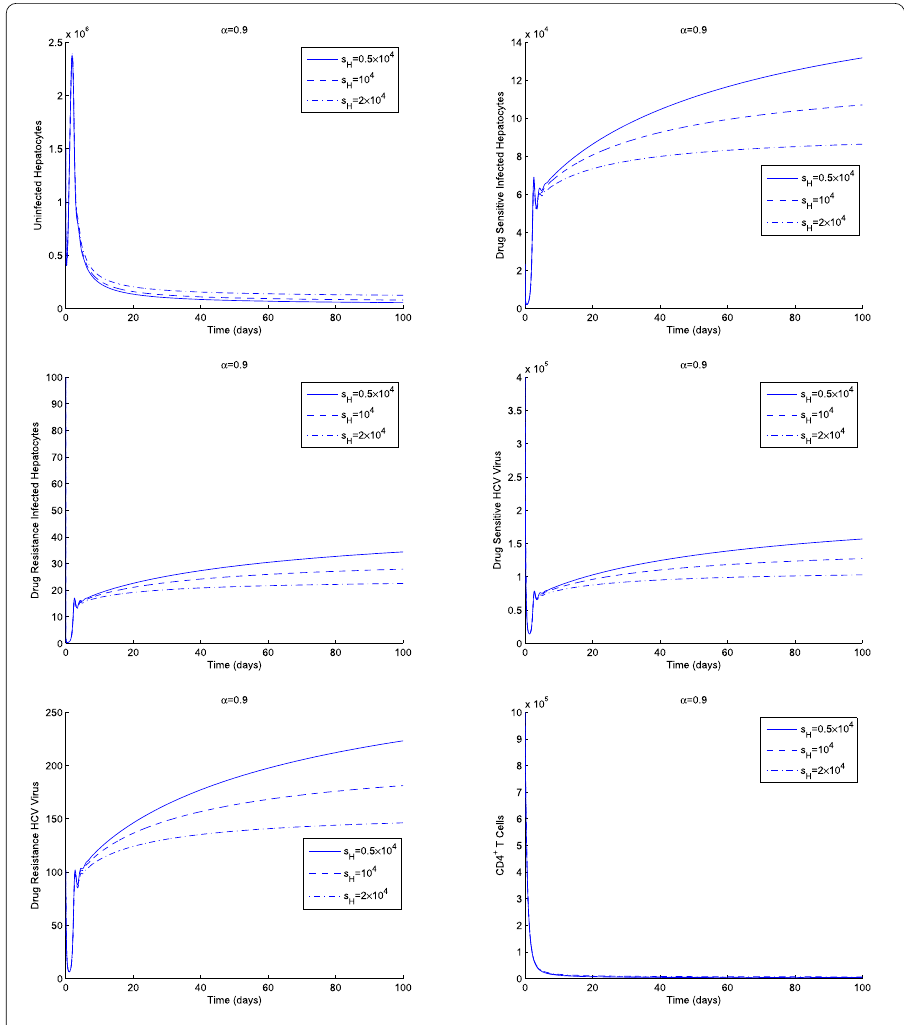
Figure 10 Dynamics of the variables of system (1) for different values of s H , the CD4 + T cells recruitment rate, and α = 0.9. Parameter values are in Table 1 and initial conditions are given in the text.